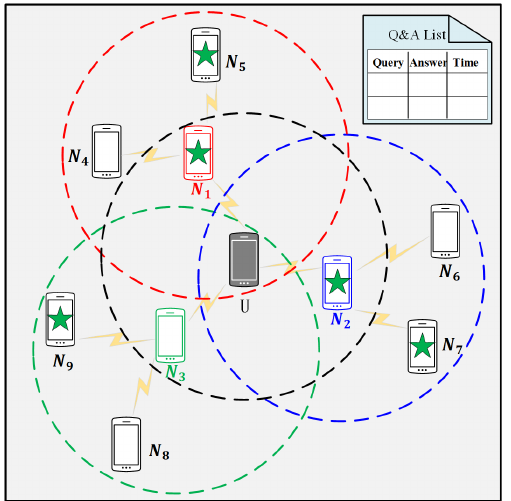
Figure 2. Query to neighboring